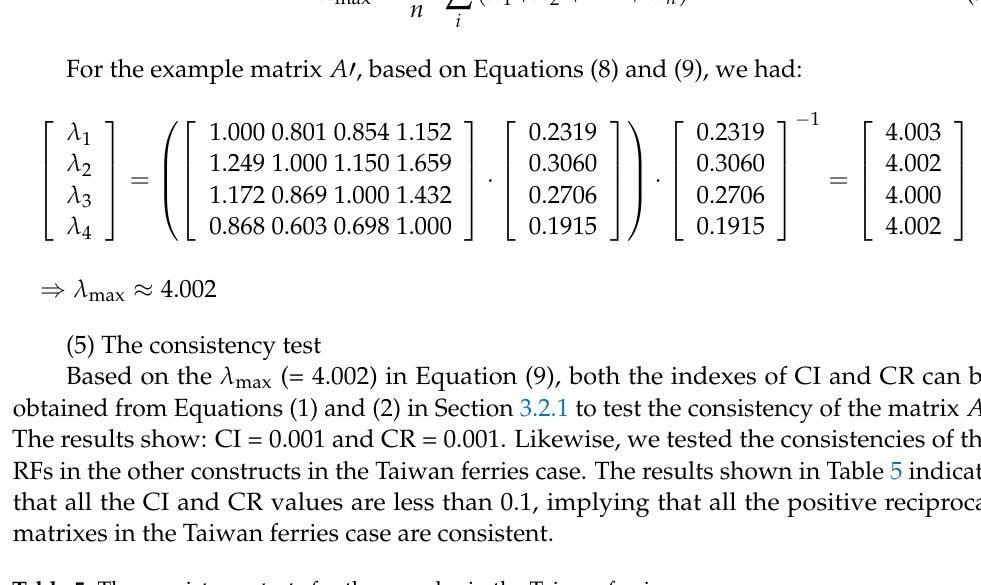
Table 5. The consistency tests for the samples in the Taiwan ferries case.